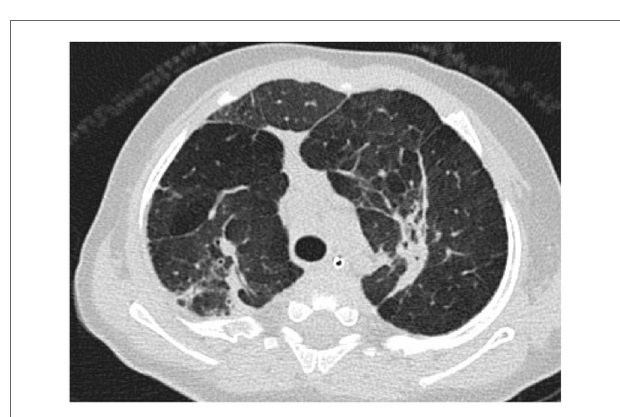
FigURe 1 | Chest radiograph demonstrating widespread coarse interstitial markings, atelectasis, and regions of hyperexpansion (particularly at the left lung base), typical of bronchopulmonary dysplasia. Note also the right upper lobe consolidation and malposition of the NG